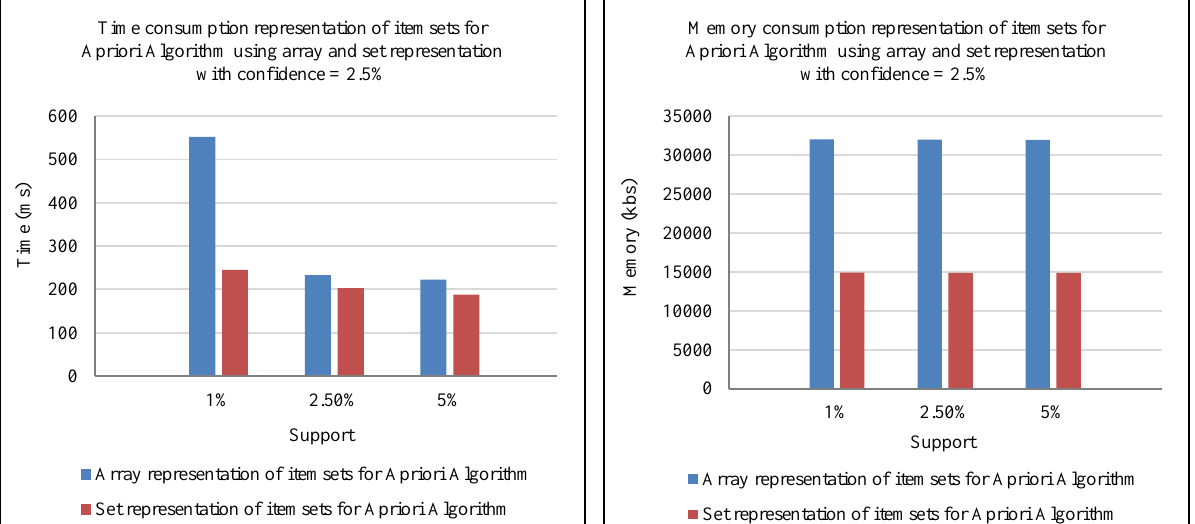
Figure 6. Time and memory consumption of Apriori Algorithm using set and array representation with confidence= 1%.